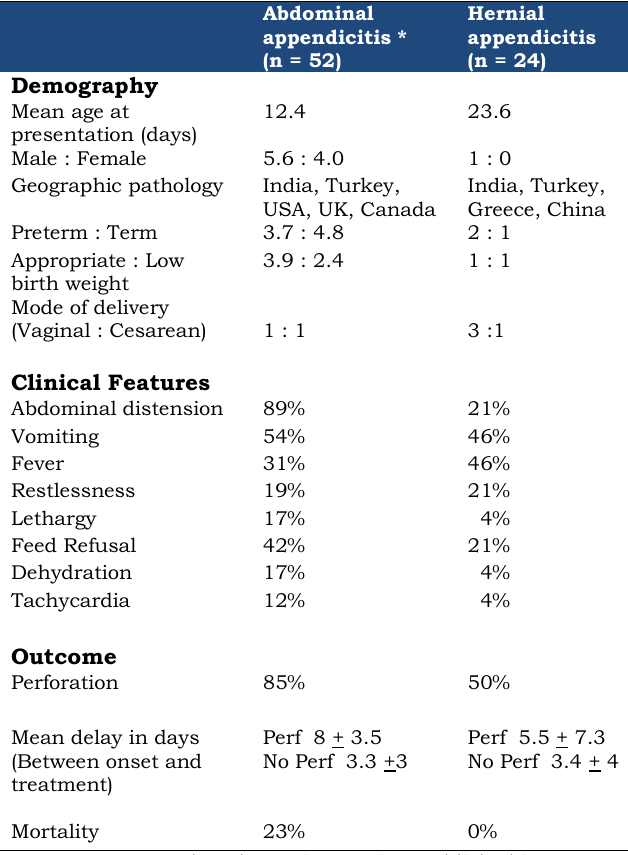
Table 2: Comparison of abdominal and hernial appendicitis